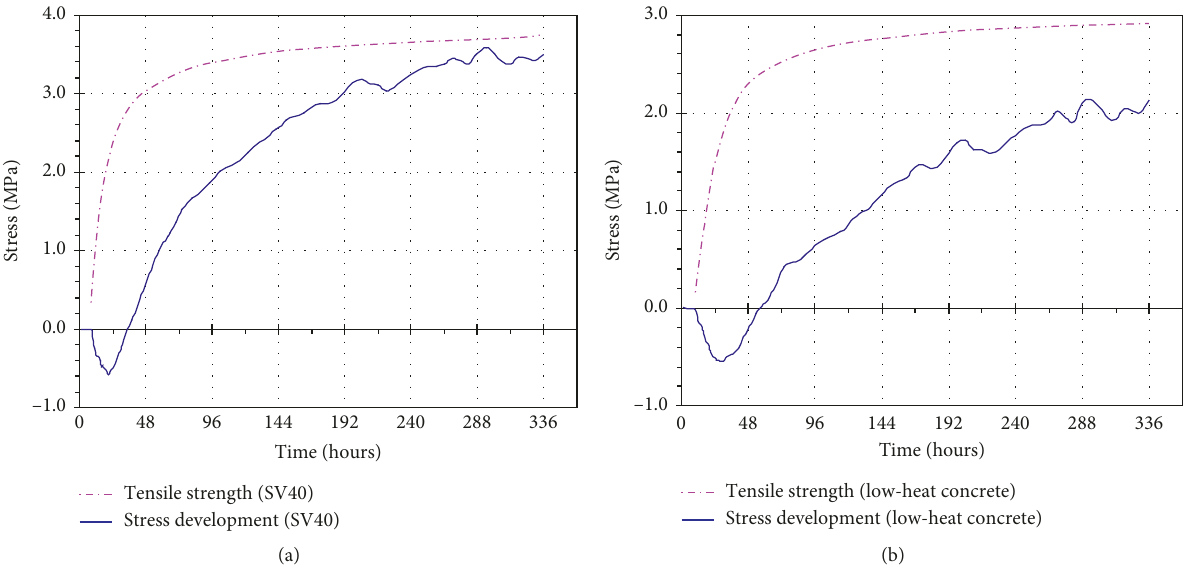
Figure 15: Stress and tensile strength developments in (a) SV40 and (b) low-heat concretes.